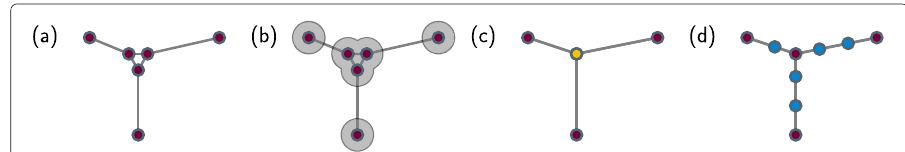
Fig. 10 Illustration of the coarse graining process. a The original network. b The three nodes in the center are smaller than a predefined buffer. c Hence they are merged into a single node. d In each of the edges, intermediary nodes are introduced so that most of the new edges have the same edge length. Note that at one end of the original edges, the new edge is slightly smaller than the target length